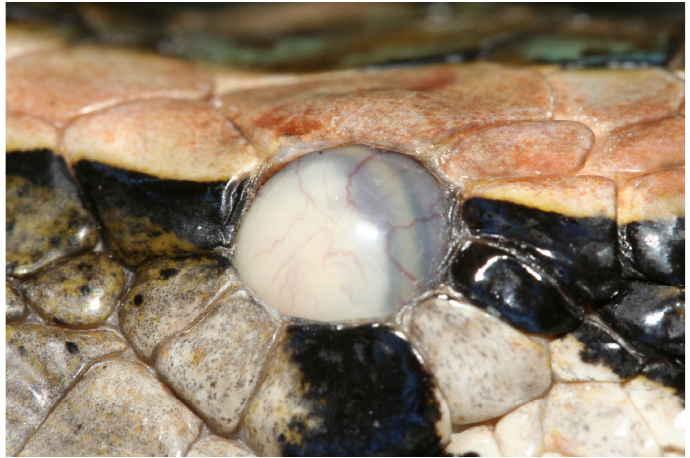
Figure 30. Flocculent exudate causing partial opacification of the subspectacular space and mild engorgement of the blood vessels of the spectacle in a Burmese python ( Python bivittatus ).